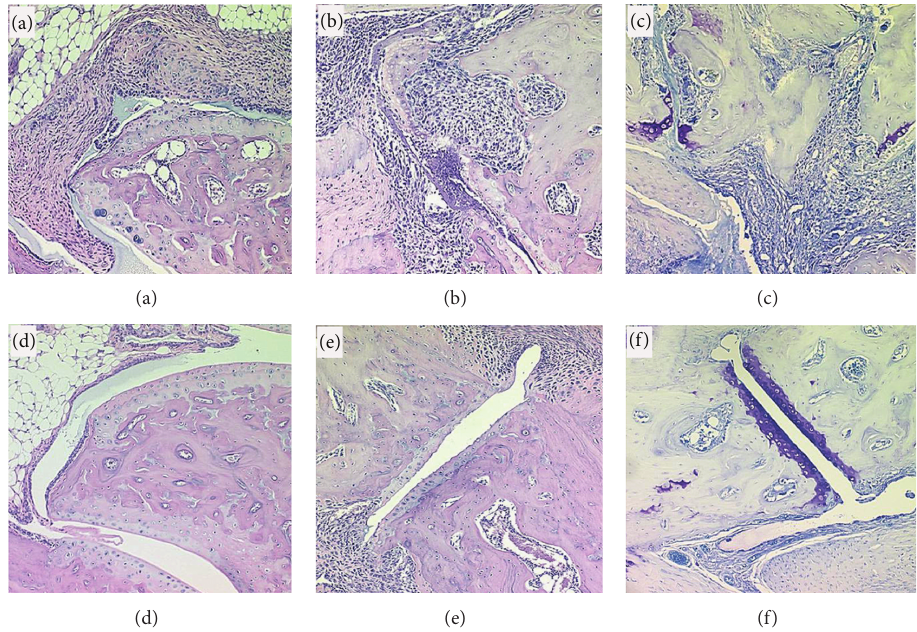
Figure 3: (a)–(c) Typical histological appearance of CIA mouse paws: (a) severe inflammatory cellular infiltration—synovitis and pannus formation; (b) bone and cartilage erosion; (c) toluidine blue stained section showing destruction of articular cartilage with loss of joint space and complete architecture distortion. Panels (d)–(f), example histological images of mouse paws after OPG gene modification: joint space was maintained and dramatically less bone and cartilage damage were obvious. (f) A Toluidine Blue stained paw section showing the protection effect on articulating cartilage.